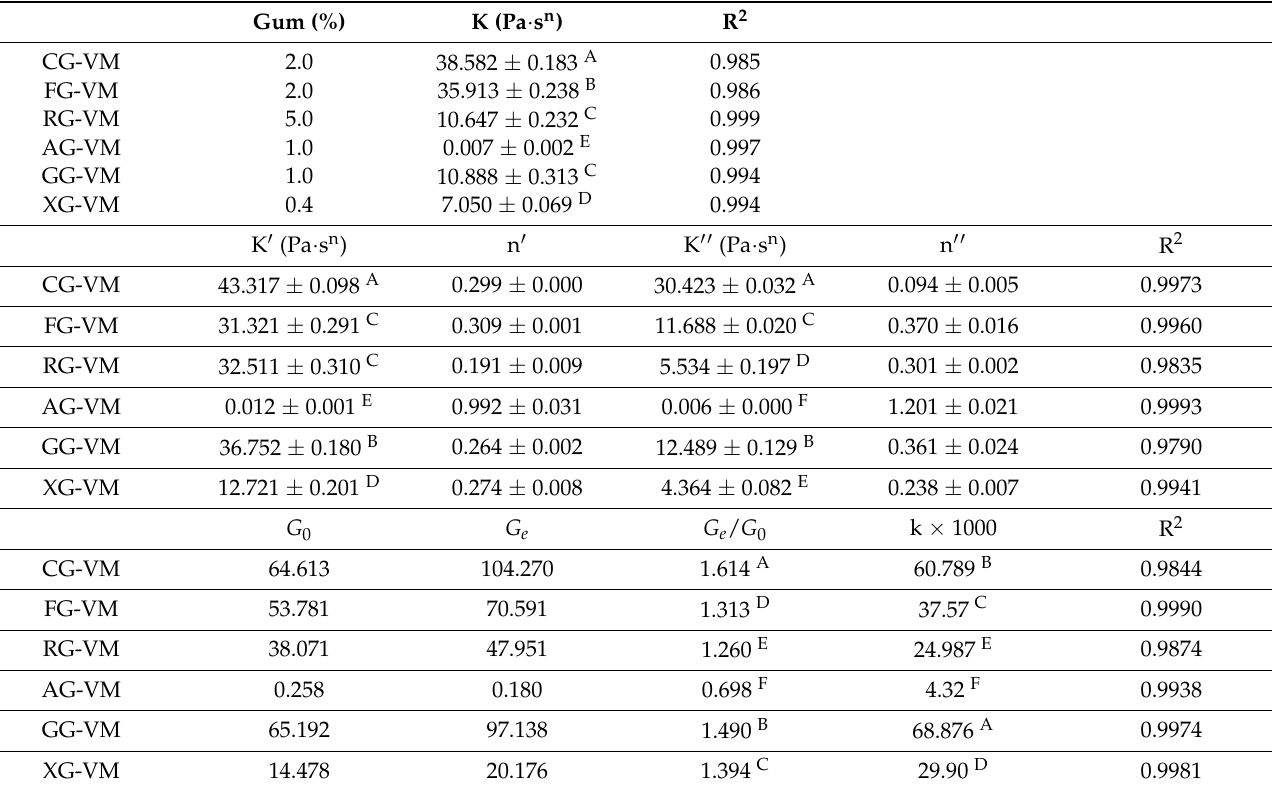
Table 6. Rheological properties of low-fat vegan mayonnaise samples * with a different type of